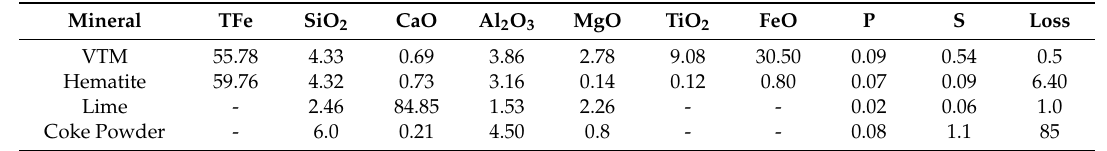
Table 2. Mixture composition.